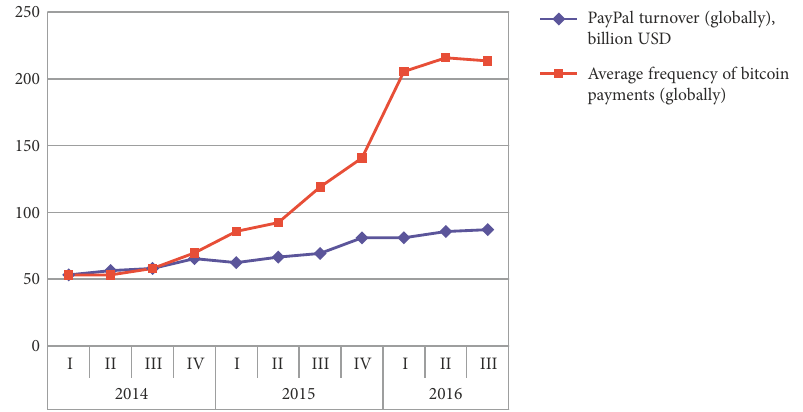
Figure 3. PayPal turnover (globally), billion USD and average frequency of bitcoin payments (globally), times a day, dynamics during 2014–2016 (Source: compiled by the authors with the reference to data from